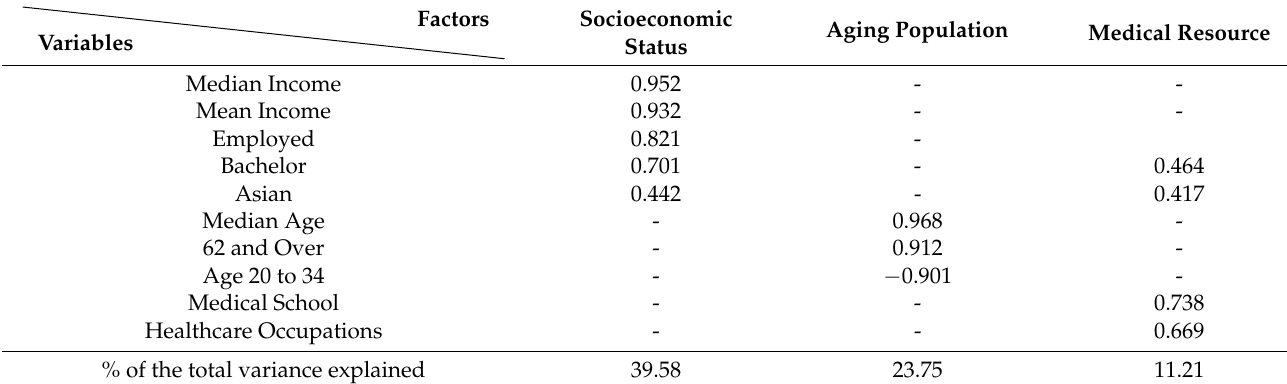
Table 6. Factors with loading coefficients.